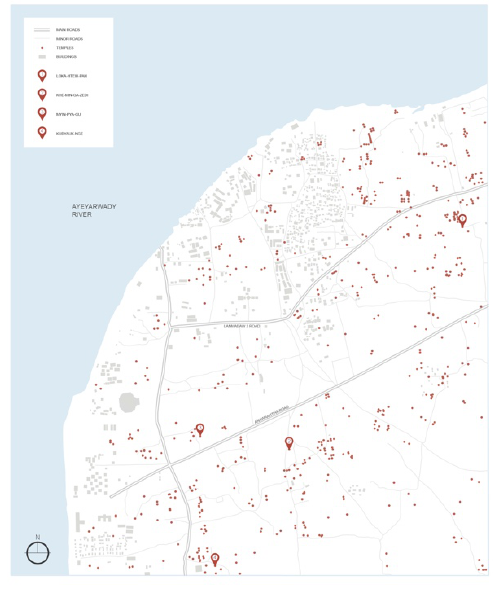
Figure 2. Map of Bagan, Myanmar